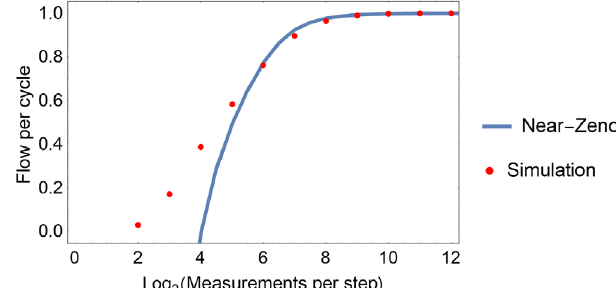
FIG. 10. Flow per cycle as the measurements per step moves away from the Zeno limit. Compared are the values found from the near-Zeno limit approximation, Eq. (30) with the trans- formation Eq. (42), and the flow found from direct simulation. Both analytics and simulations are done in the perfect switching cycle, i.e., ð T= 8 Þ ¼ ð π = 2 Þ . our measurement protocol away from the Zeno limit. In